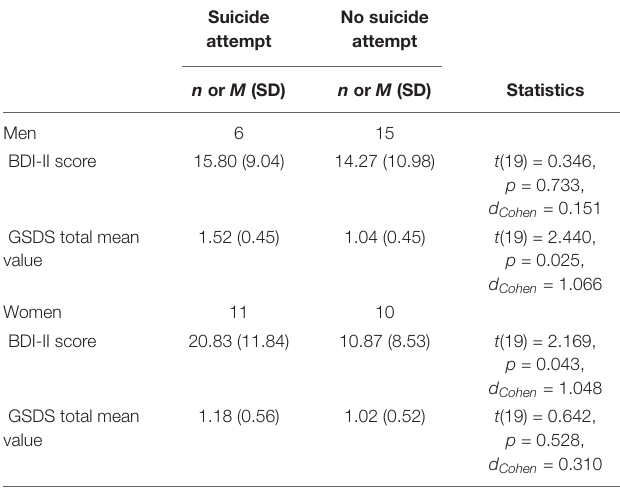
TABLE 4 | Comparison of patients with and without a history of suicide attempt in an age- and BDI-II score-matched sample of male ( n = 21) and female ( n = 21) forensic psychiatric